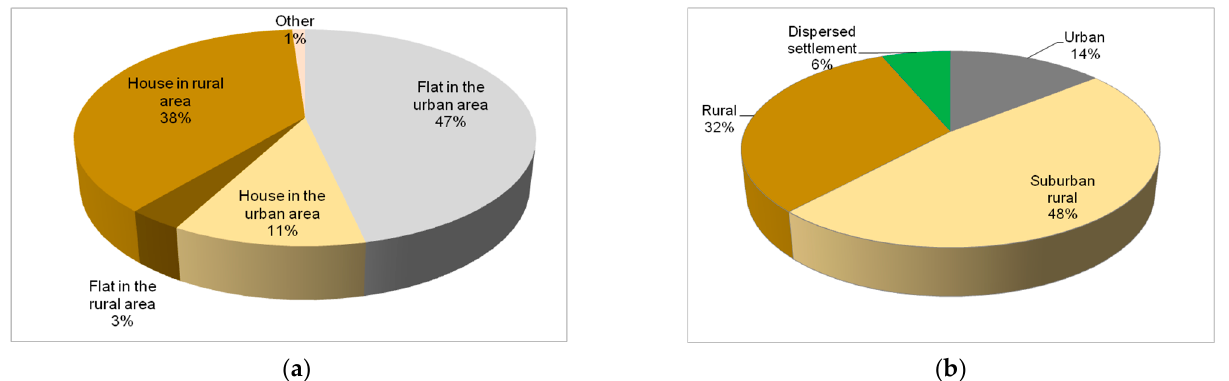
Figure 5. The landscape preference for housing: ( a ) current status of living and ( b ) landscape preference, or where they would like to live.